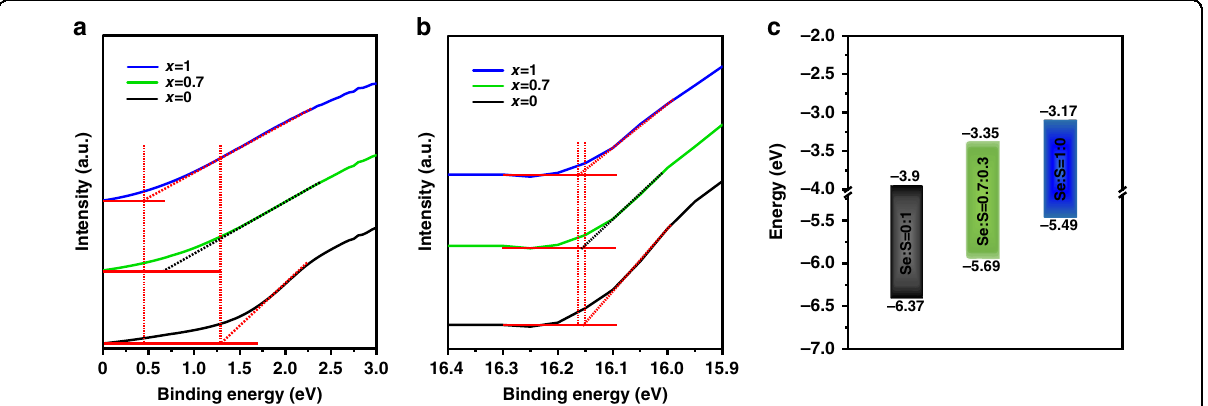
Fig. 4 The energy level of InP/ZnSe x S 1 − x /ZnS QDs. UPS spectra of a the valence-band edge regions and b the secondary cutoff regions of InP/ ZnSe x S 1 − x /ZnS QDs ( x = 0, 0.7, 1). c Energy level diagram of corresponding